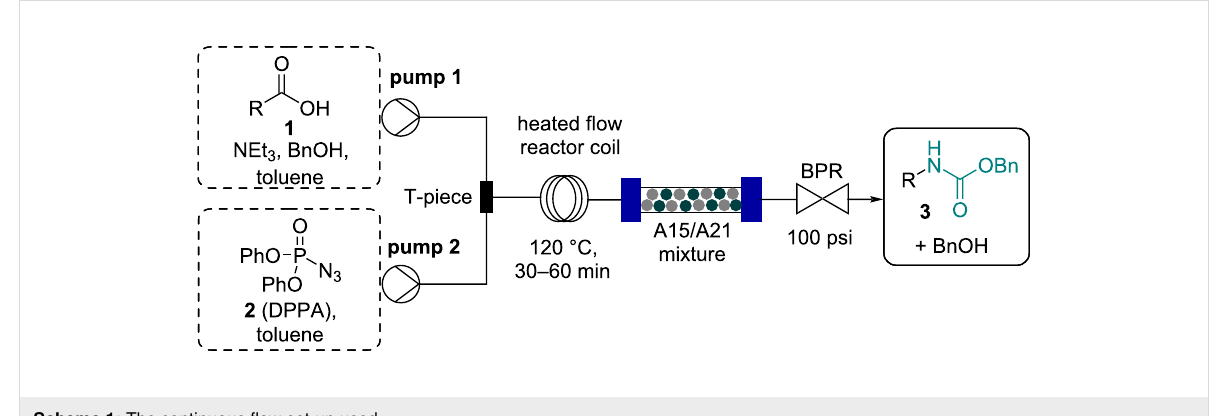
Scheme 1: The continuous flow set-up